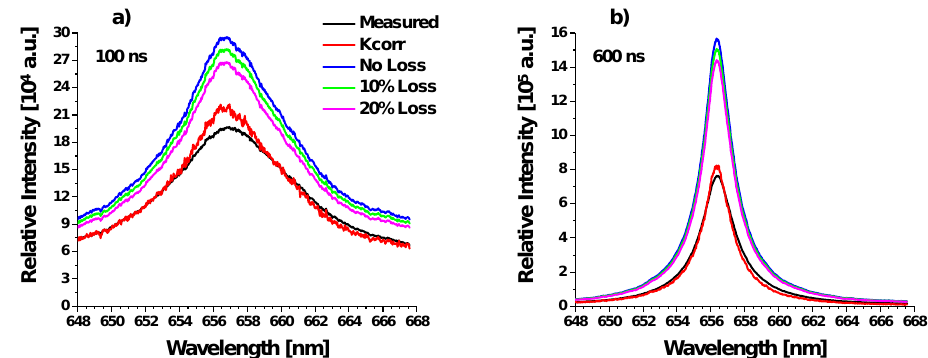
Figure 7. Results of correcting the H α spectrum using the methods of Equations (8) and (9) and also directly calculating the optical depth with assumed losses in conjunction with Equation (7) for ( a ) 100ns and ( b ) 400 ns time delays in the plasma